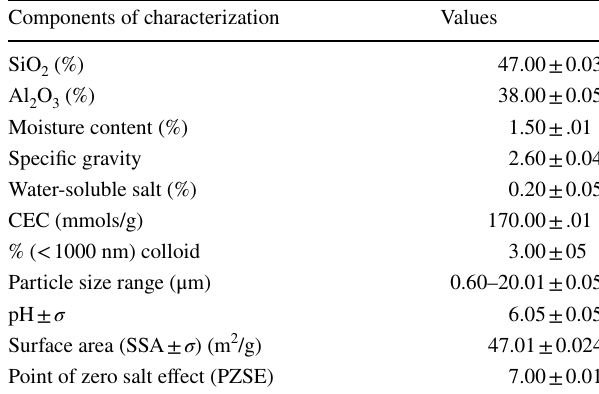
Table 1 Summary of adsorbent (kaolinite) characterization (Egirani et al. 2017a) Components of